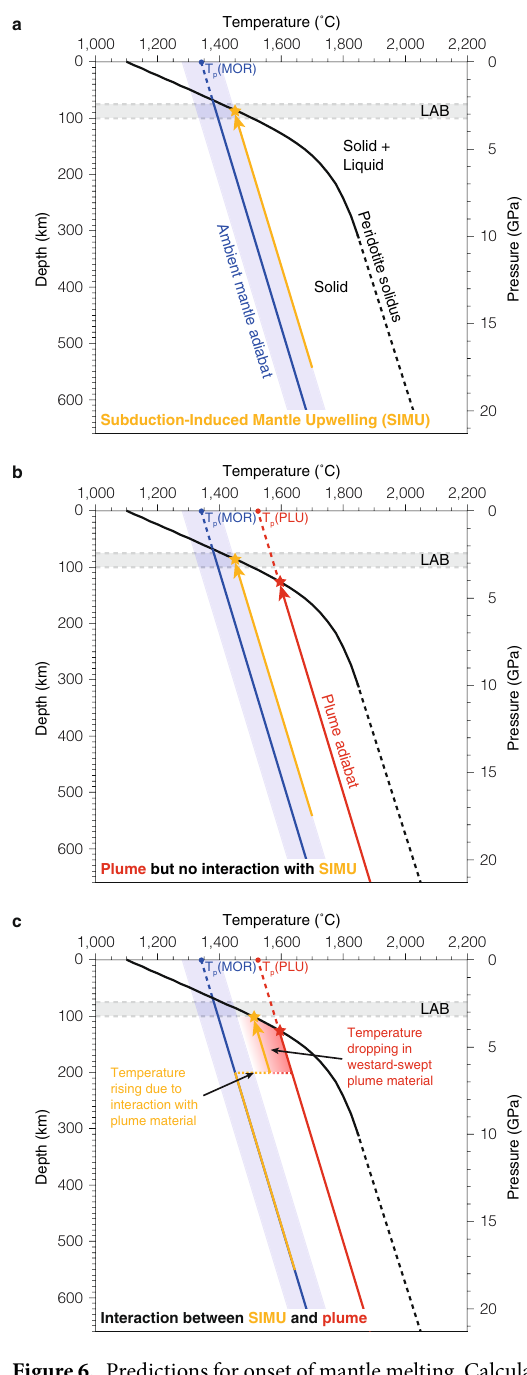
Figure 6. Predictions for onset of mantle melting. Calculations to explain mantle melting by: ( a ) SIMU only; ( b ) Samoan plume only (no interaction with SIMU); ( c ) SIMU interacting with Samoan plume. In ( c ) the onset of mantle melting is facilitated because the SIMU drives decompression melting in the westward-swept Samoan plume material, thus producing the non-hotpot volcanism occurring west of the Samoan hotspot after 5